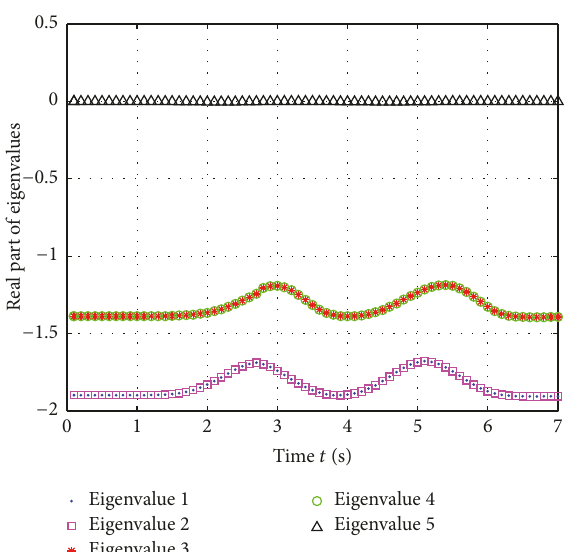
Figure 12: Changes in real parts of calculated eigenvalues with control in critical single-lane